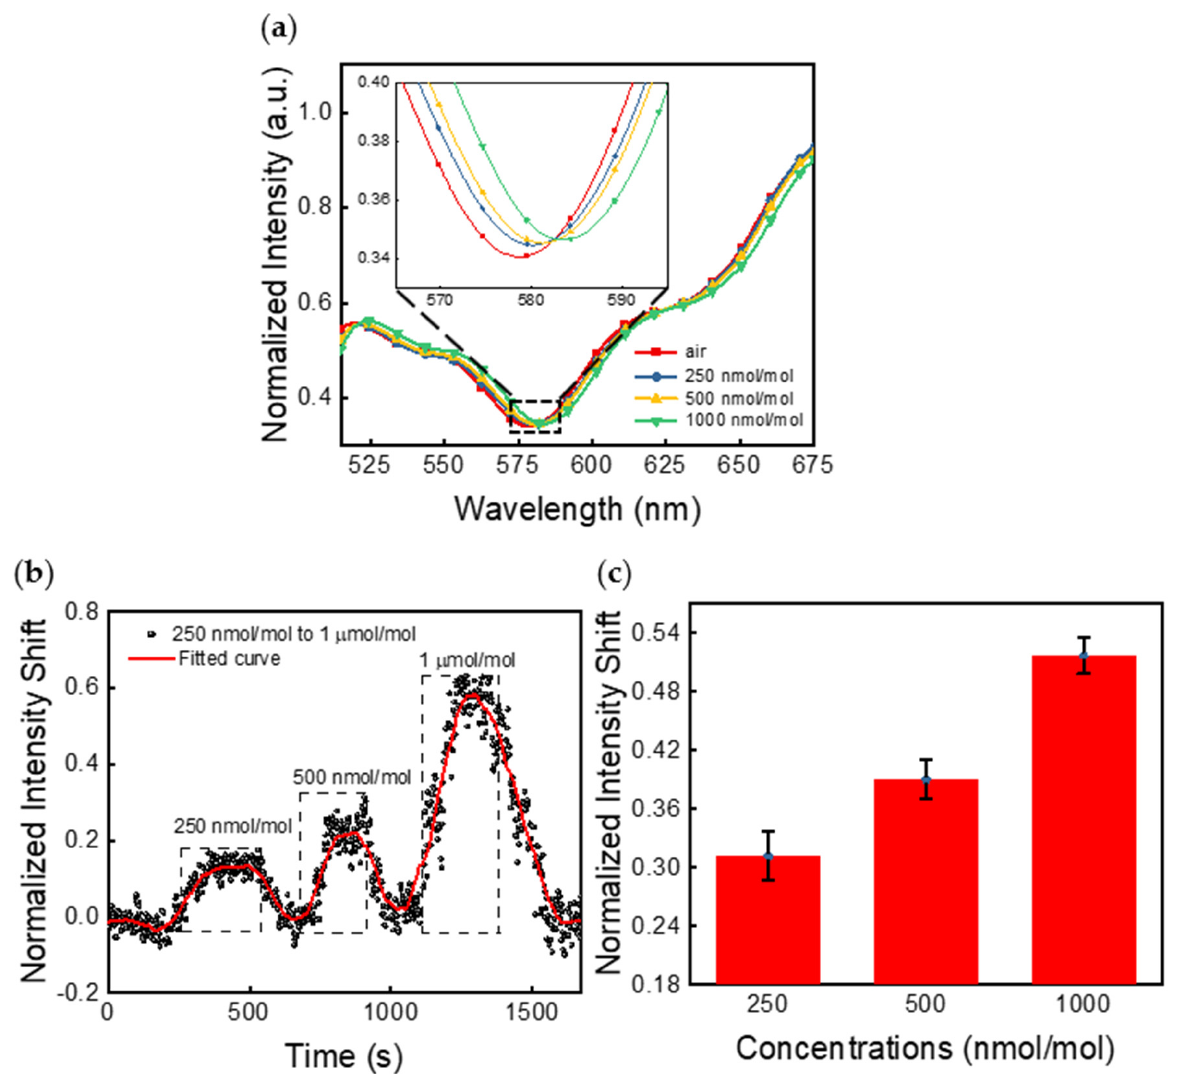
Figure 3. ( a ) Peak wavelength and intensity shift response of the NHA sensor when exposed to varying acetaldehyde concentrations in a dry air background. ( b ) The NHA sensor response to acetaldehyde for 250 nmol/mol, 500 nmol/mol, and 1 µ mol/mol at a wavelength of 583.5 nm. The dotted boxes represent the input periods of the target analyte at each concentration. To help with visualization, a trend curve generated with the Savitzky–Golay method was overlaid. ( c ) Normalized intensity shifts of NHA sensors when exposed to varying acetaldehyde concentrations. Error bars along the y -axis represent ± 1 standard deviation for measurement results captured in 5 different testing trials on 4 sensor chips.